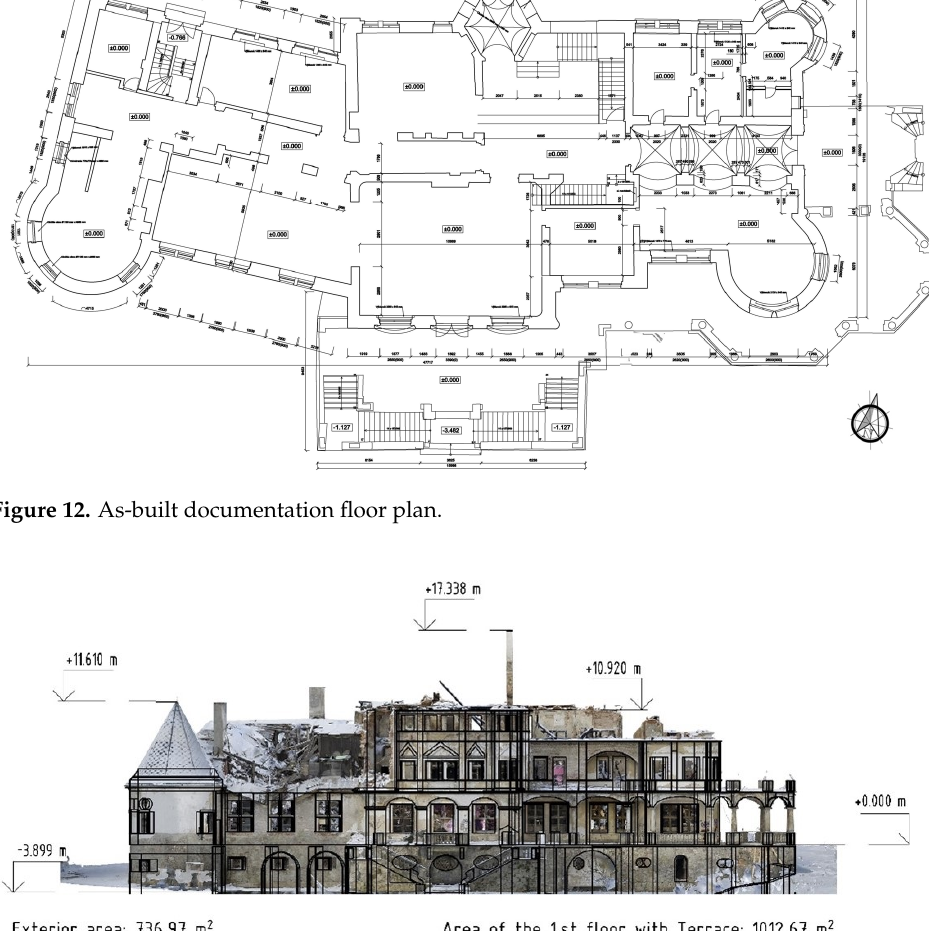
Figure 13. West view of the researched object.